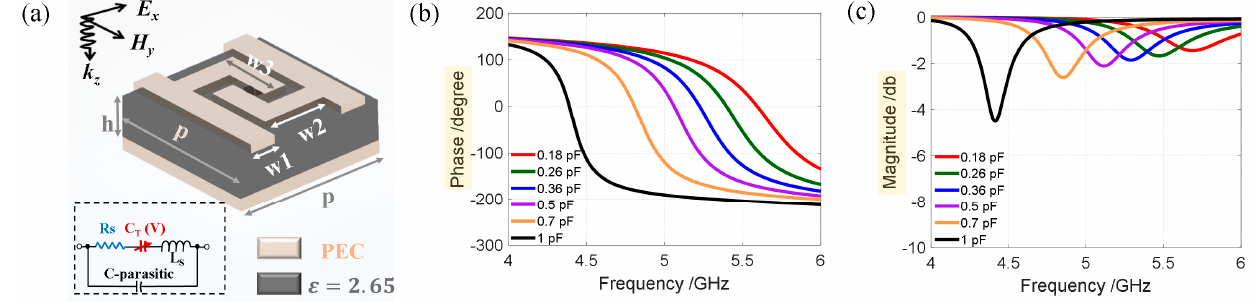
Figure 3. ( a ) 3D view of the designed unit cell. p = 10 mm, w 1 = 1.5 mm, w 2 = 4.2 mm, w 3 = 4.5 mm, h = 2.5 mm. ( b , c ): Reflection phase and amplitude at different capacitances and frequen- cies, respectively.